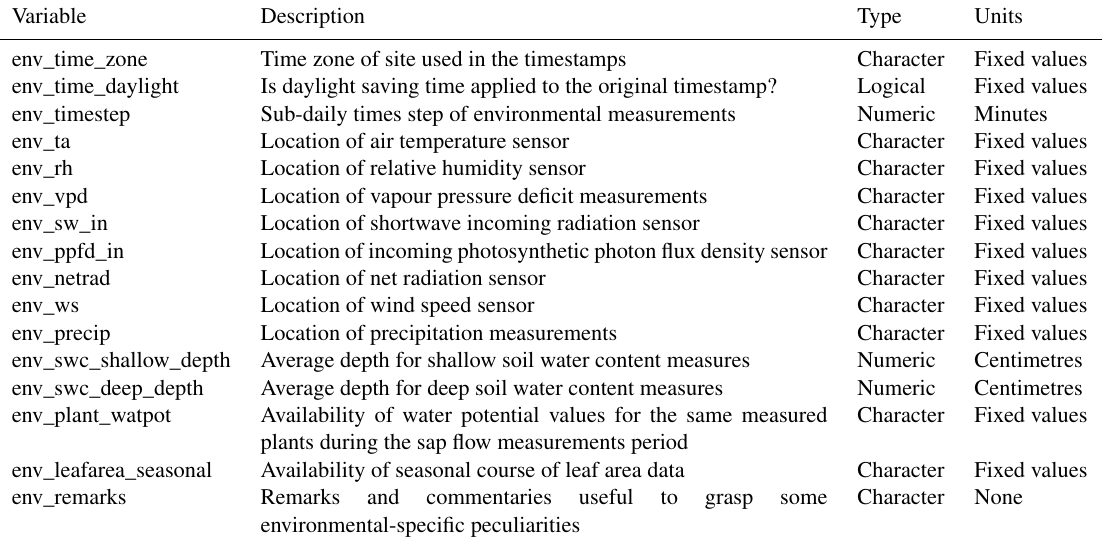
Table A6. Description of environmental metadata variables in SAPFLUXNET datasets.